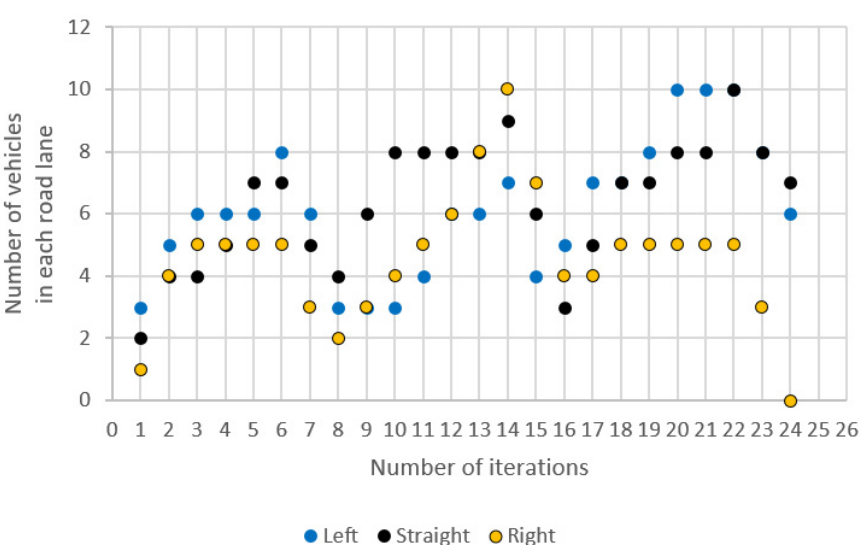
Figure 7. Number of vehicles with a declared direction of travel.